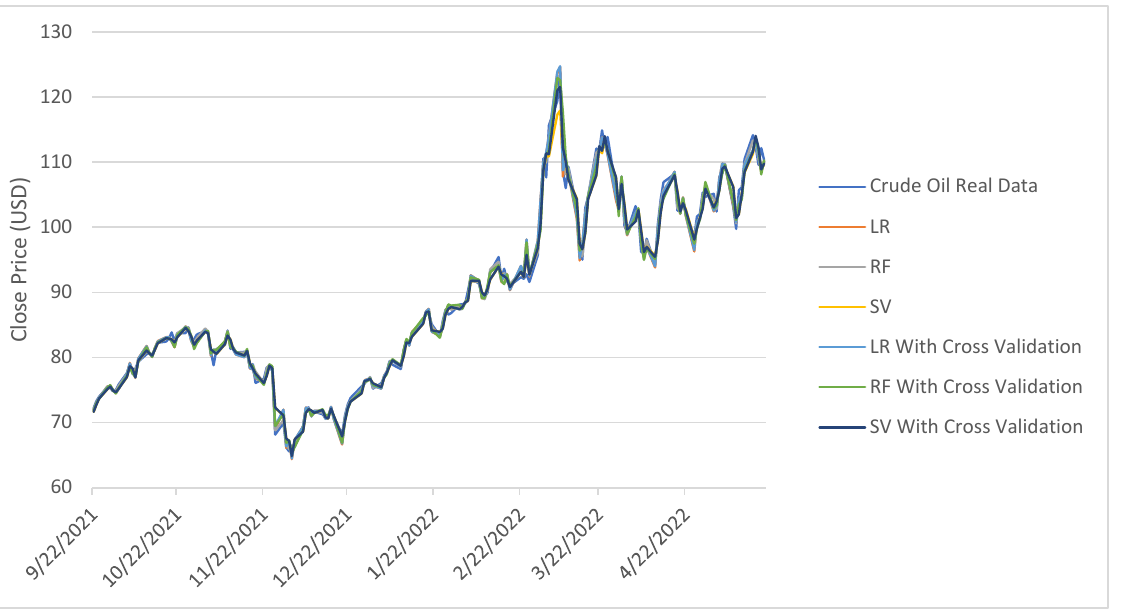
Figure 6. Results for eight months with the effect of COVID-19 for two